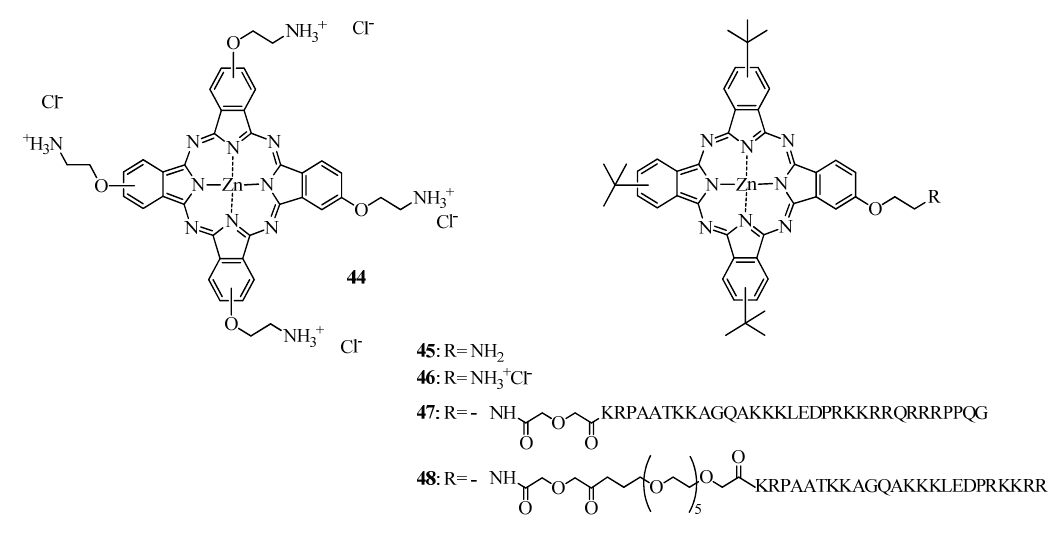
Figure 16. Chemical structure of compounds 44–48